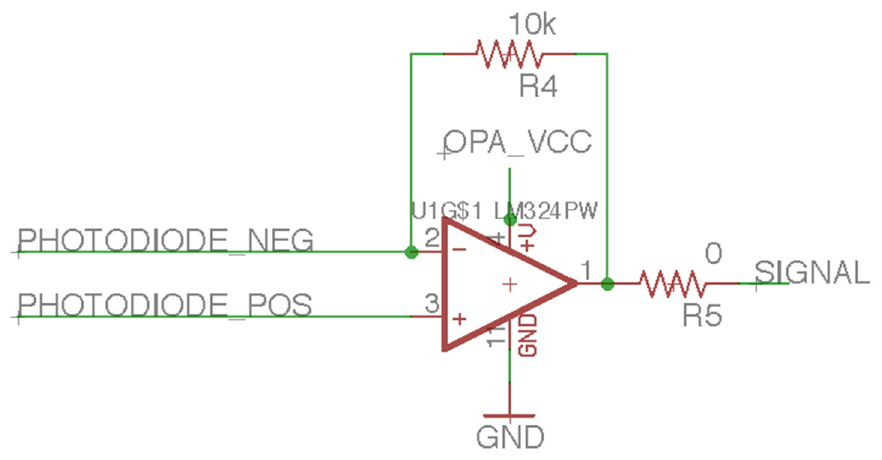
Figure 10. The trans-impedance amplifier of the laser audio signal receiver circuit.